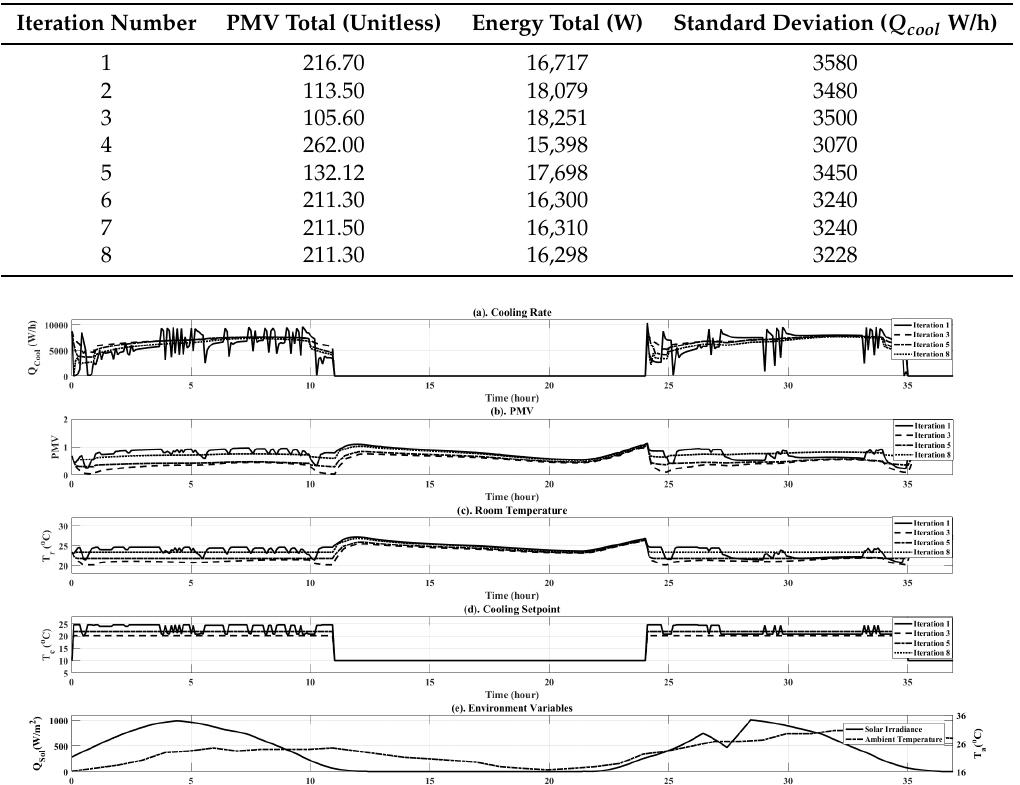
Figure 9. Simulation results plots for the RL controller at various iterations of training. Plots are shown for both objective variables ( Q cool and PMV), as well as additional simulation data, such as ambient temperature and solar irradiance.